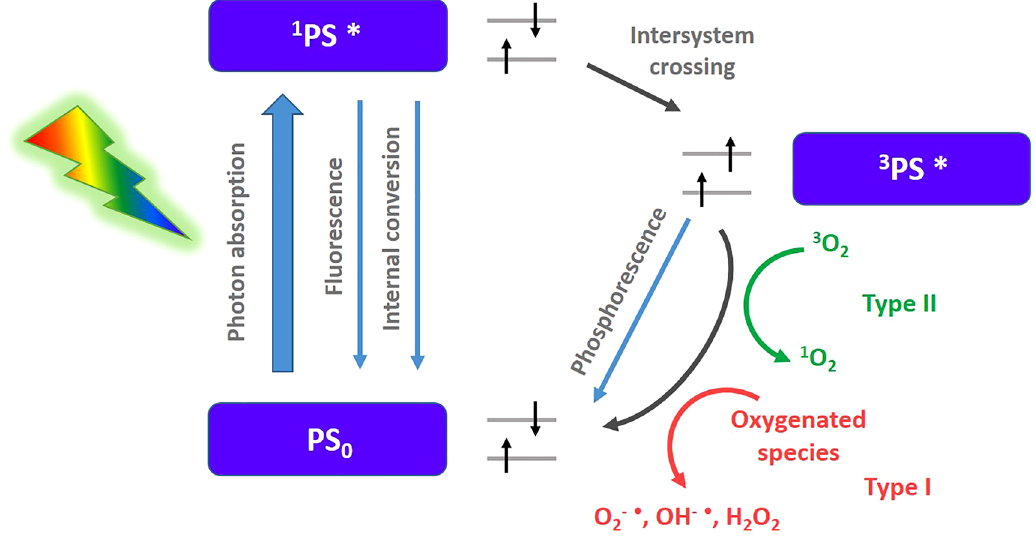
Figure 1: Modified Jablonski diagram showing the role of the photosensitizer (PS) in photodynamic therapy